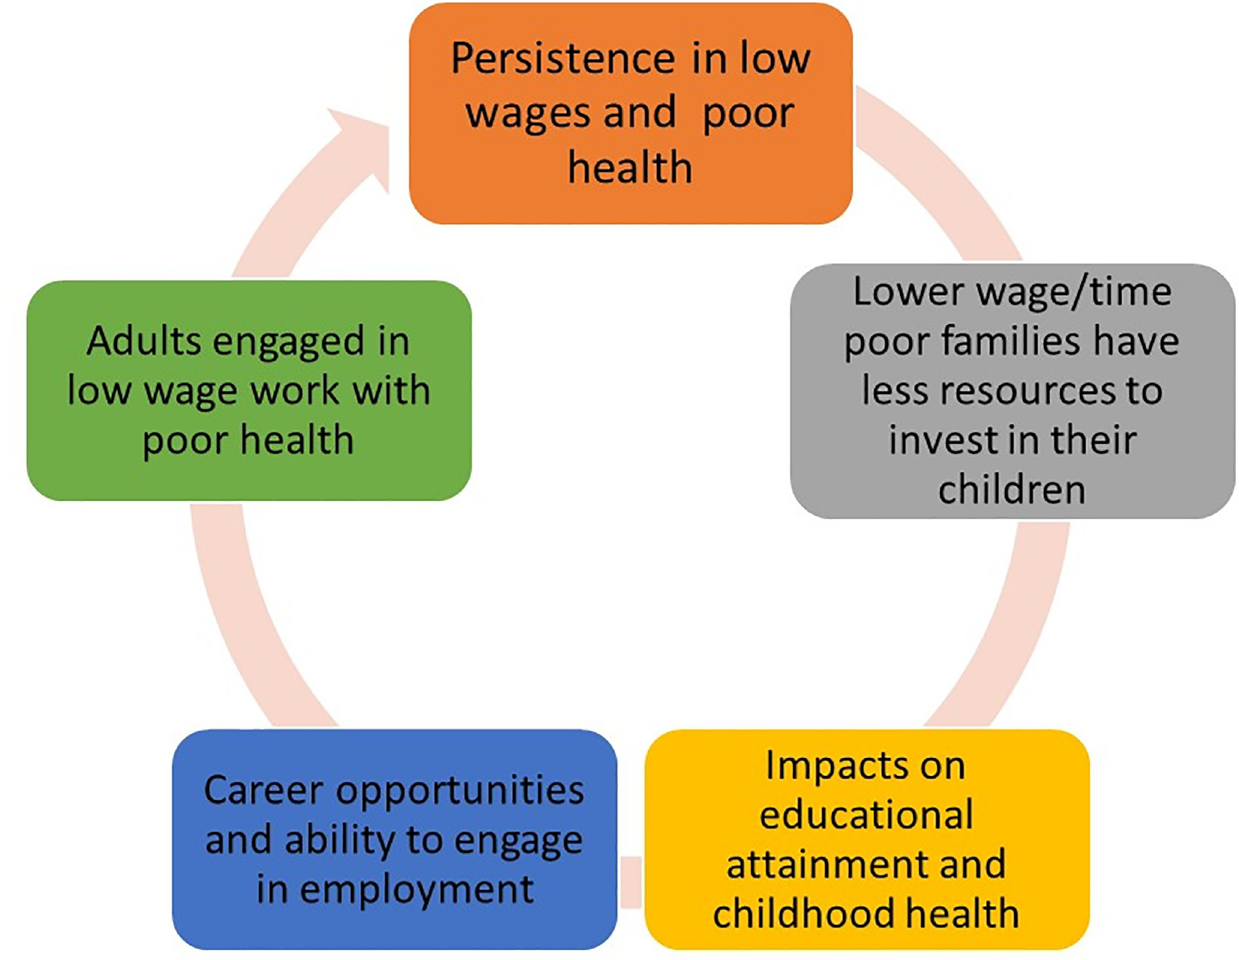
Fig 1. The poverty and poor health trap.